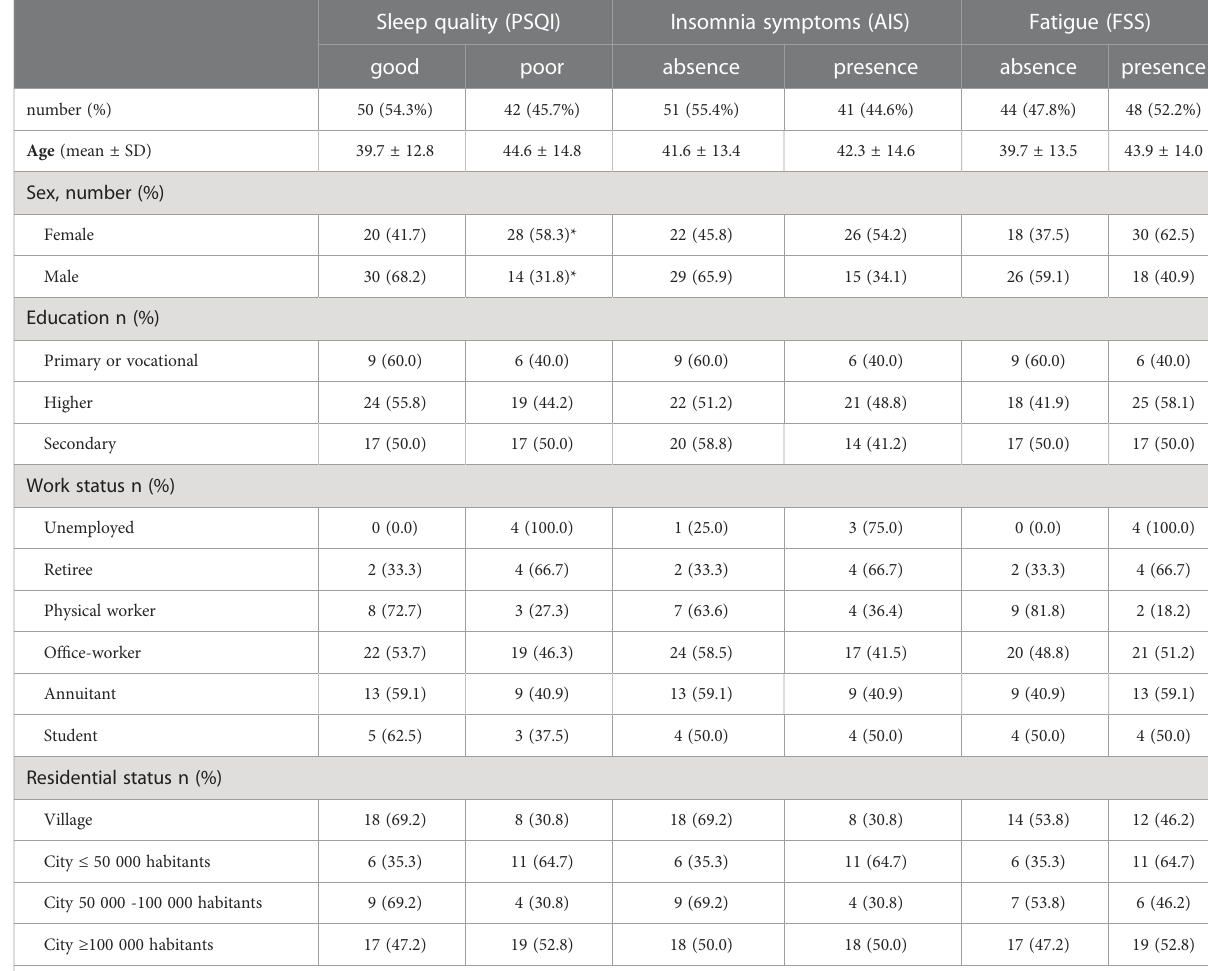
TABLE 3 Comparison of patients with good or poor sleep quality (PSQI), absence or presence of insomnia symptoms, and absence or presence of fatigue symptoms according to sociodemographic data. Sleep quality